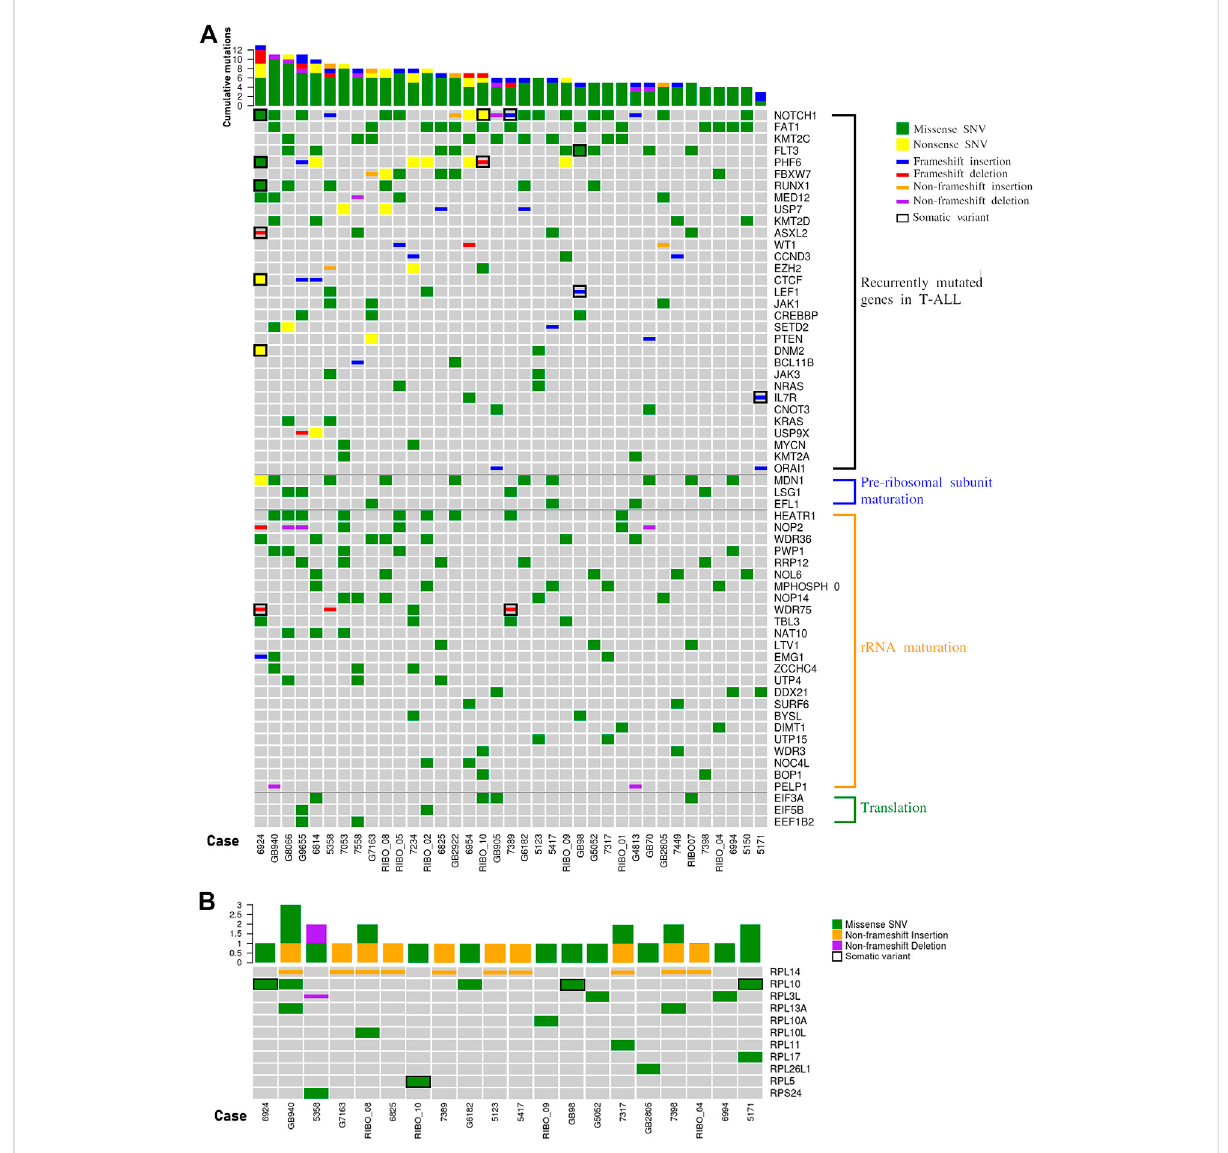
FIGURE 2 The landscape of mutations in pediatric T-ALL samples. (A) overview of variations in T-ALL driver genes (recurrently mutated genes in T-ALL) and other genes involved in ribosome biogenesis (pre-ribosomal subunit maturation and rRNA maturation) or in translational control. In the graphs only genes harbouring variations in at least two patients are represented. The total number of mutations per patient is represented by histograms at the top of the heatmap. (B) Overview of variations in ribosomal proteins. In the graph only those samples with at least one variation in genes encoding for ribosomal protein are reported. The total number of RP mutations per patient is represented by histograms at the top of the heatmap. SNV: single nucleotide